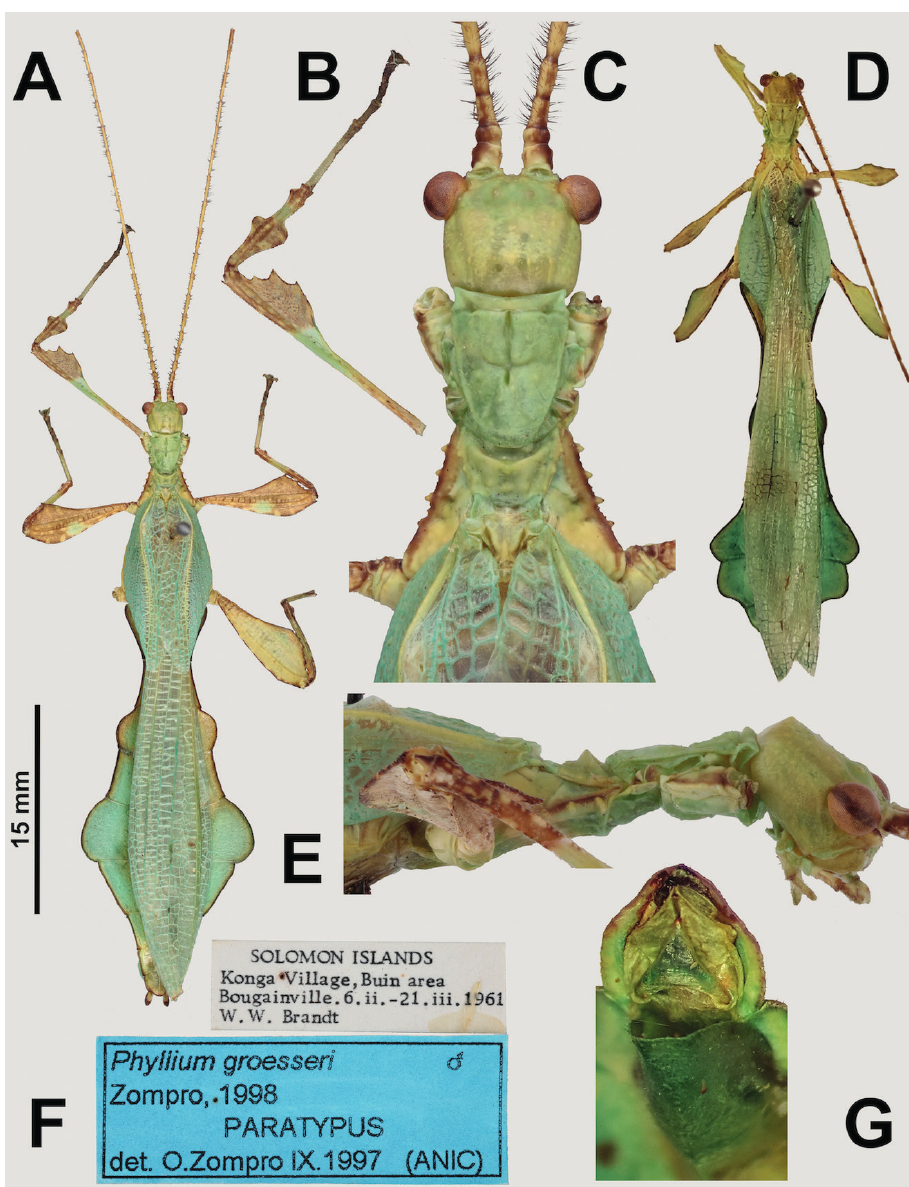
Figure 11. Vaabonbonphyllium groesseri comb. nov. males A–C, E, F paratype male, (ANIC (CSIRO)), photographs by Bonnie Koopmans (CSIRO) D, G non-type male (NHMUK), photographs by first au- thor A habitus, dorsal (left front leg is physically detached, photoshopped onto the specimen for this figure) B left front leg, dorsal C details of head through thorax, dorsal D habitus, dorsal E details of head through thorax, lateral F associated data labels G genitalia, ventral. Scale bar only associated with A